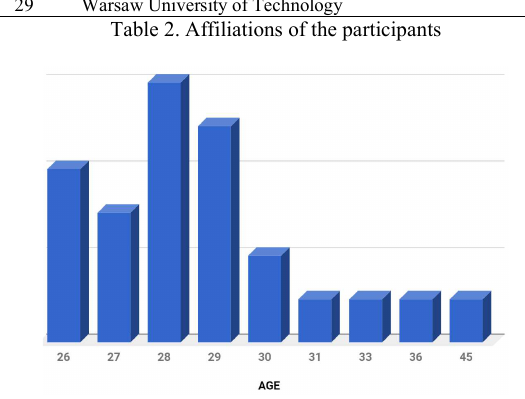
Figure 8. Age distribution of participants